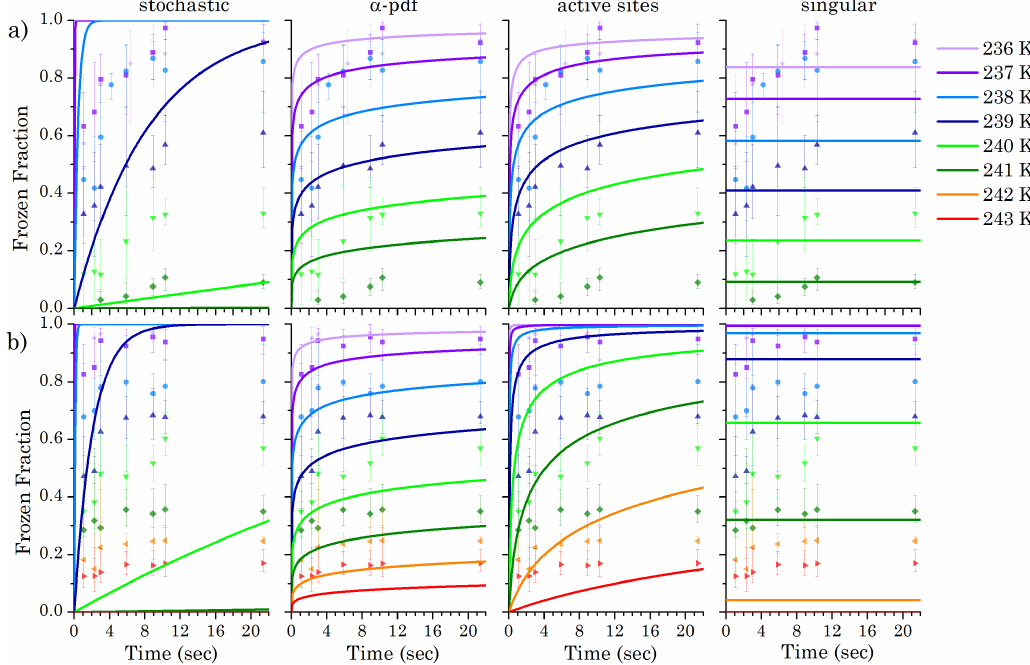
Fig. 7. Comparison of the fit curves obtained with the four models with experimental data. (a) 400nm kaolinite particles. (b) 800nm kaolinite particles. The parameters used to obtain the fit curves for both particle sizes are given in Table 2. The error bars represent the uncertainty in the distinction between water and ice with the IODE detector. See Sect. 2.4 for